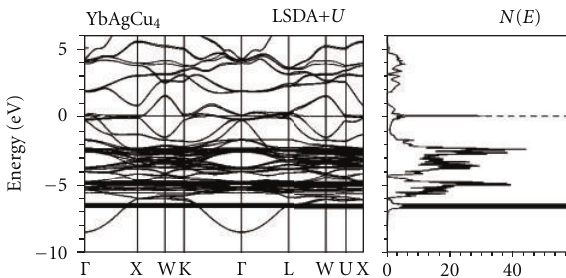
Figure 100: LSDA+ U self-consistent fully relativistic, spin-polar- ized energy band structure and total DOS (in states/(unit cell eV)) of YbAgCu 4 ( U e ff = 6eV) [475].